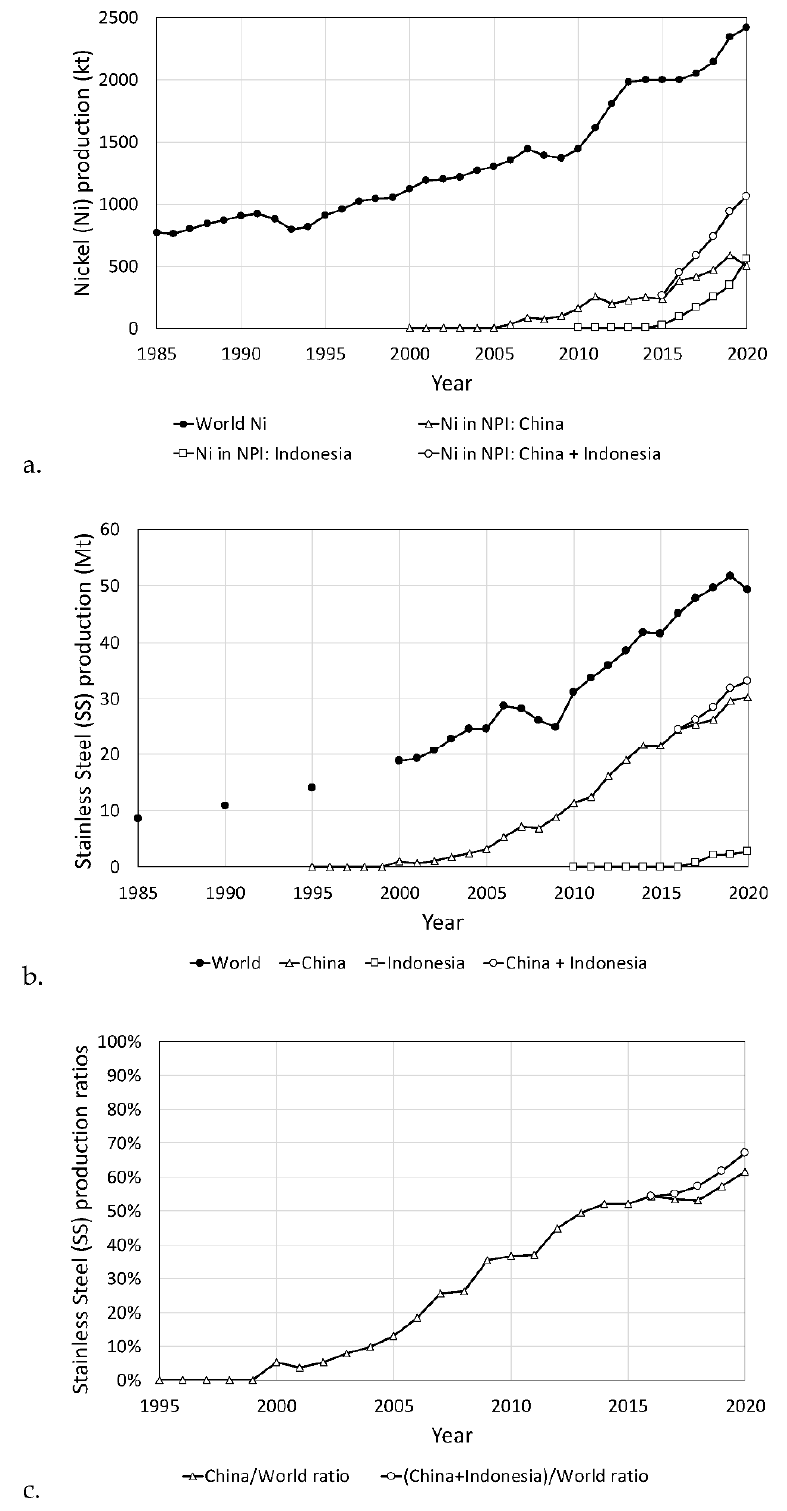
Figure 1. ( a ) Nickel production, ( b ) Stainless Steel production, and ( c ) Stainless Steel production ratios.